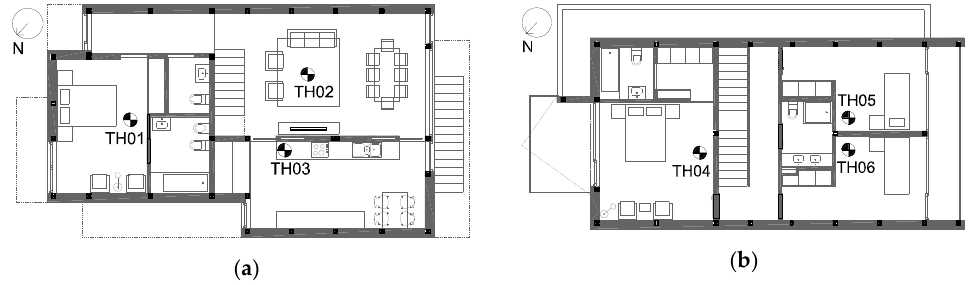
Figure 8. Identification and location of the sensors: ( a ) ground floor; ( b ) first floor. 201